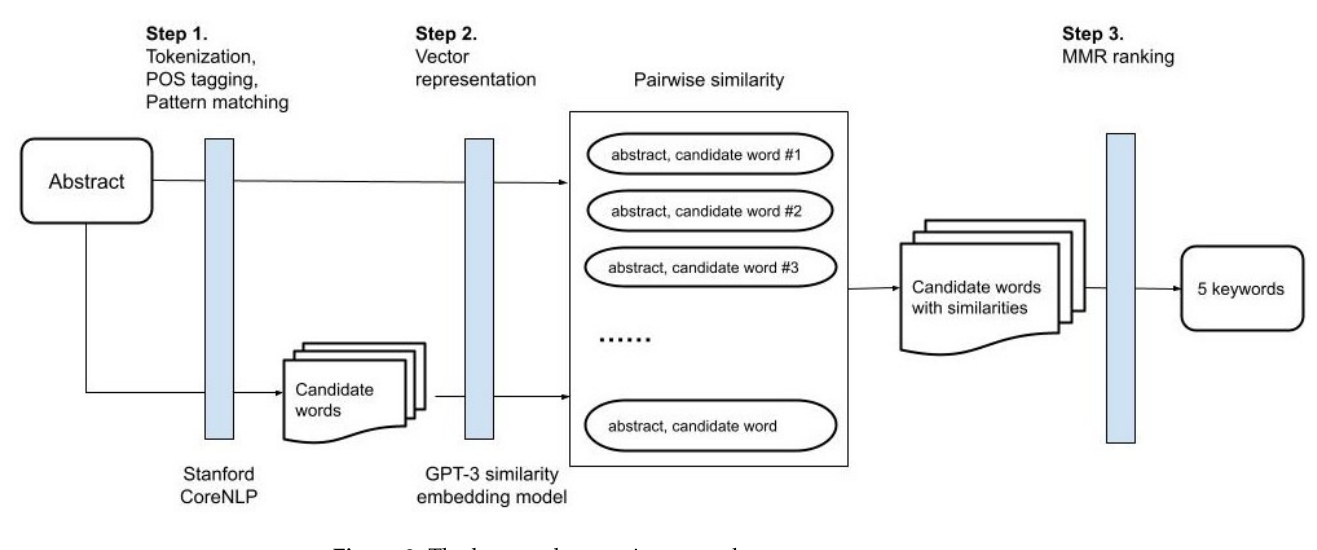
Figure 3. The keyword extraction procedure. Table 1. Syntactic patterns for candidate words and